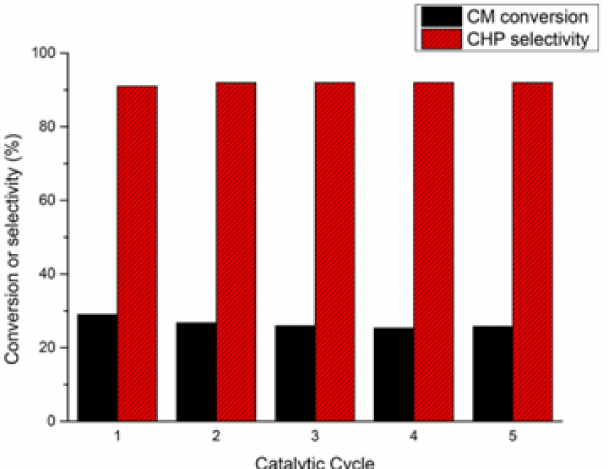
Figure 6. Reusability data of the mixed-metal Co 5 Ni-BTC MOF in five consecutive runs. Reproduced with permission from